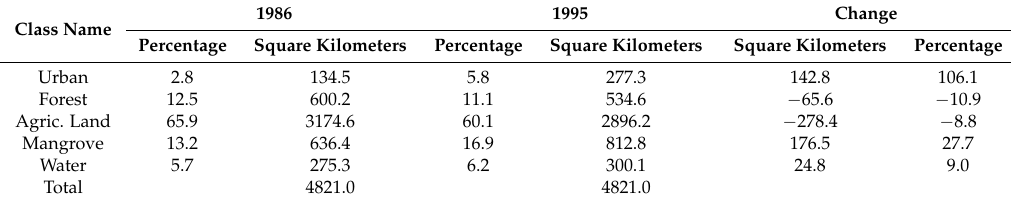
Table 3. Changes in urban area and other LULC categories between 1986–1995. Changes in this table indicate that urban area experienced a significant increase.